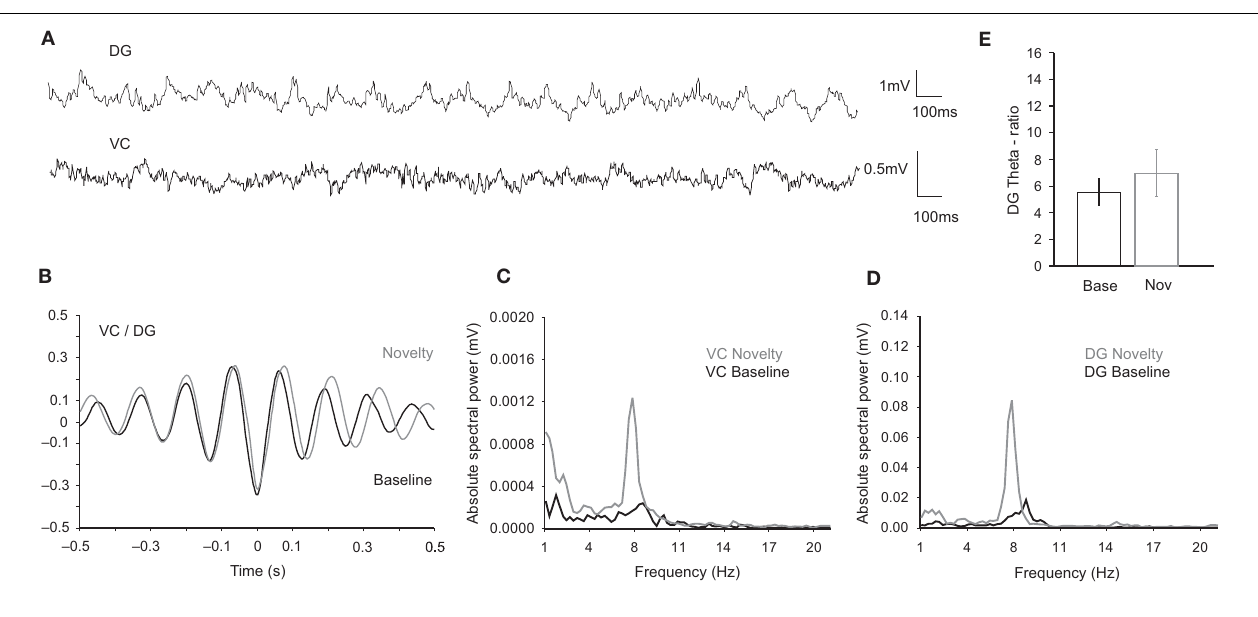
cross-correlogram during novelty exposure that corresponds to slower theta oscillations. (C) Visual cortex and (D) dentate gyrus spectral power examples during the baseline (black trace) and the novelty (grey trace) periods. Higher values are detected for the novelty theta periods in the range of 8 Hz frequency. Note the difference of the theta peak, which is in the range of 9–10 Hz for the baseline theta periods. (E) Theta-ratio baseline values (black bars) are similar in comparison to the novelty (grey bars) ones.